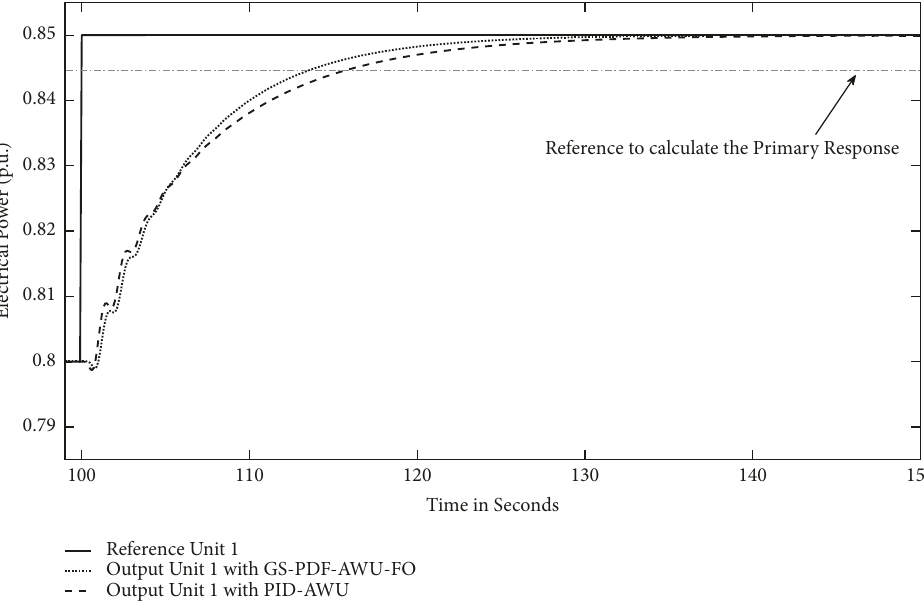
Figure 10: Step responses of PID and GS-PDF-FO, both with antiwindup, one operational unit, and